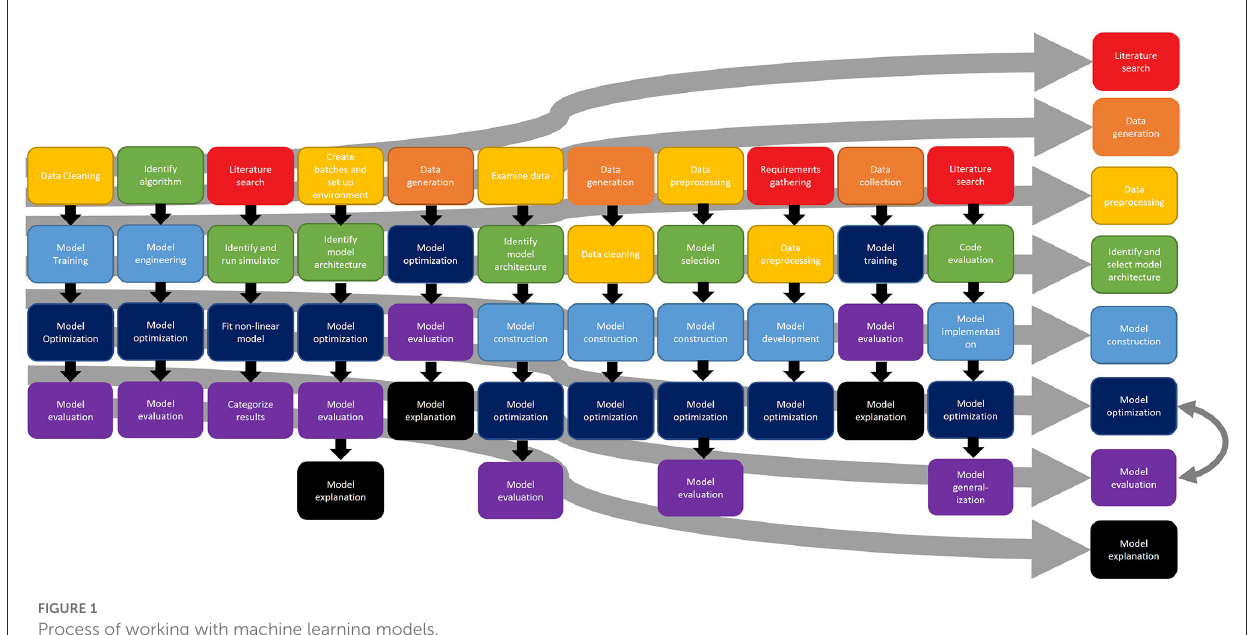
FIGURE1 Process of working with machine learning models.